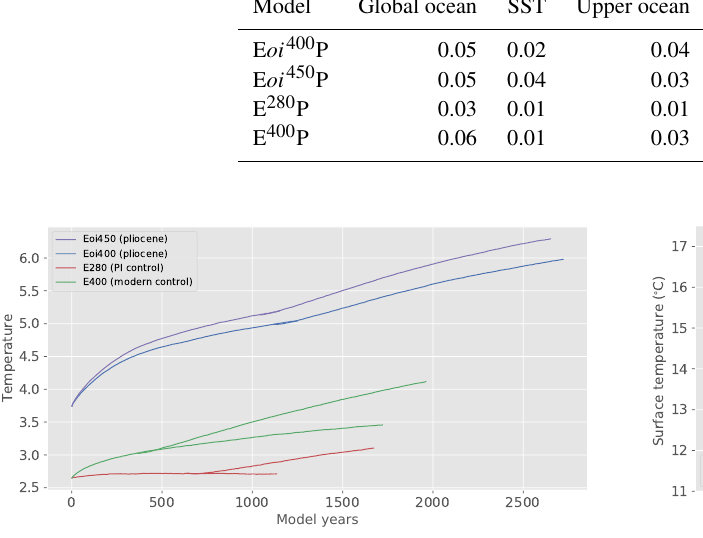
Figure 5. Evolution of the globally integrated air temperature of the atmospheric model layer closest to the surface. When a new curve “forks” from an existing curve, it represents the branching of the P version of that simulation in which the ocean model κ has been fixed to the POP1 type profile. In all cases, the original simulation (with κ = 0 . 16 throughout the ocean) was also continued further in